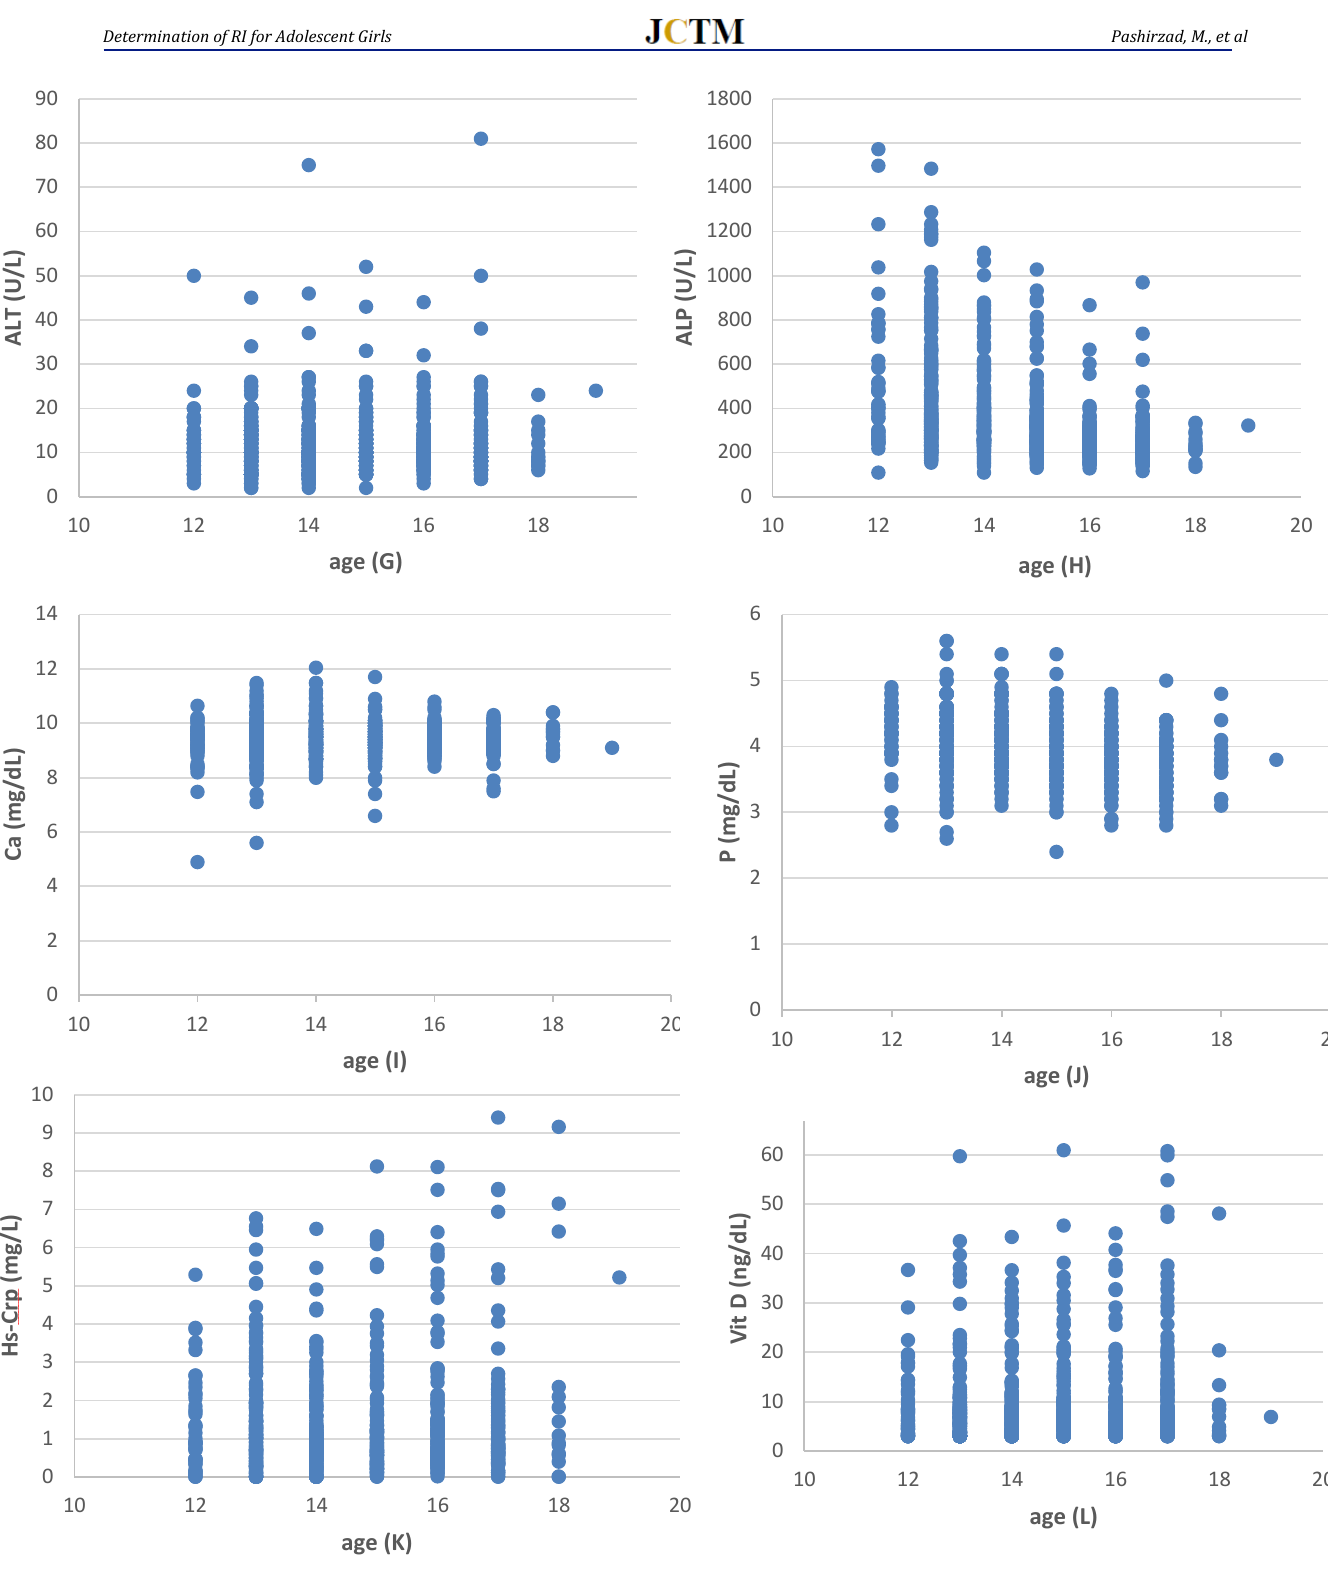
Continue Figure 1. Scatterplot distribution for serum total cholesterol (mg/dL), triglyceride (mg/dL), low- density lipoprotein (mg/dL), high-density lipoprotein (mg/dL), fasting blood sugar (mg/dL), AST (U/L), ALT (U/L), ALP (U/L), Hs-CRP (mg/L), calcium (mg/dL), phosphate (mg/dL), vitamin D (ng/dL), creatinine (mg/dL), blood urine nitrogen (mg/dL) (A-N). Blue horizontal lines depict adolescent girls-specific lower and upper reference